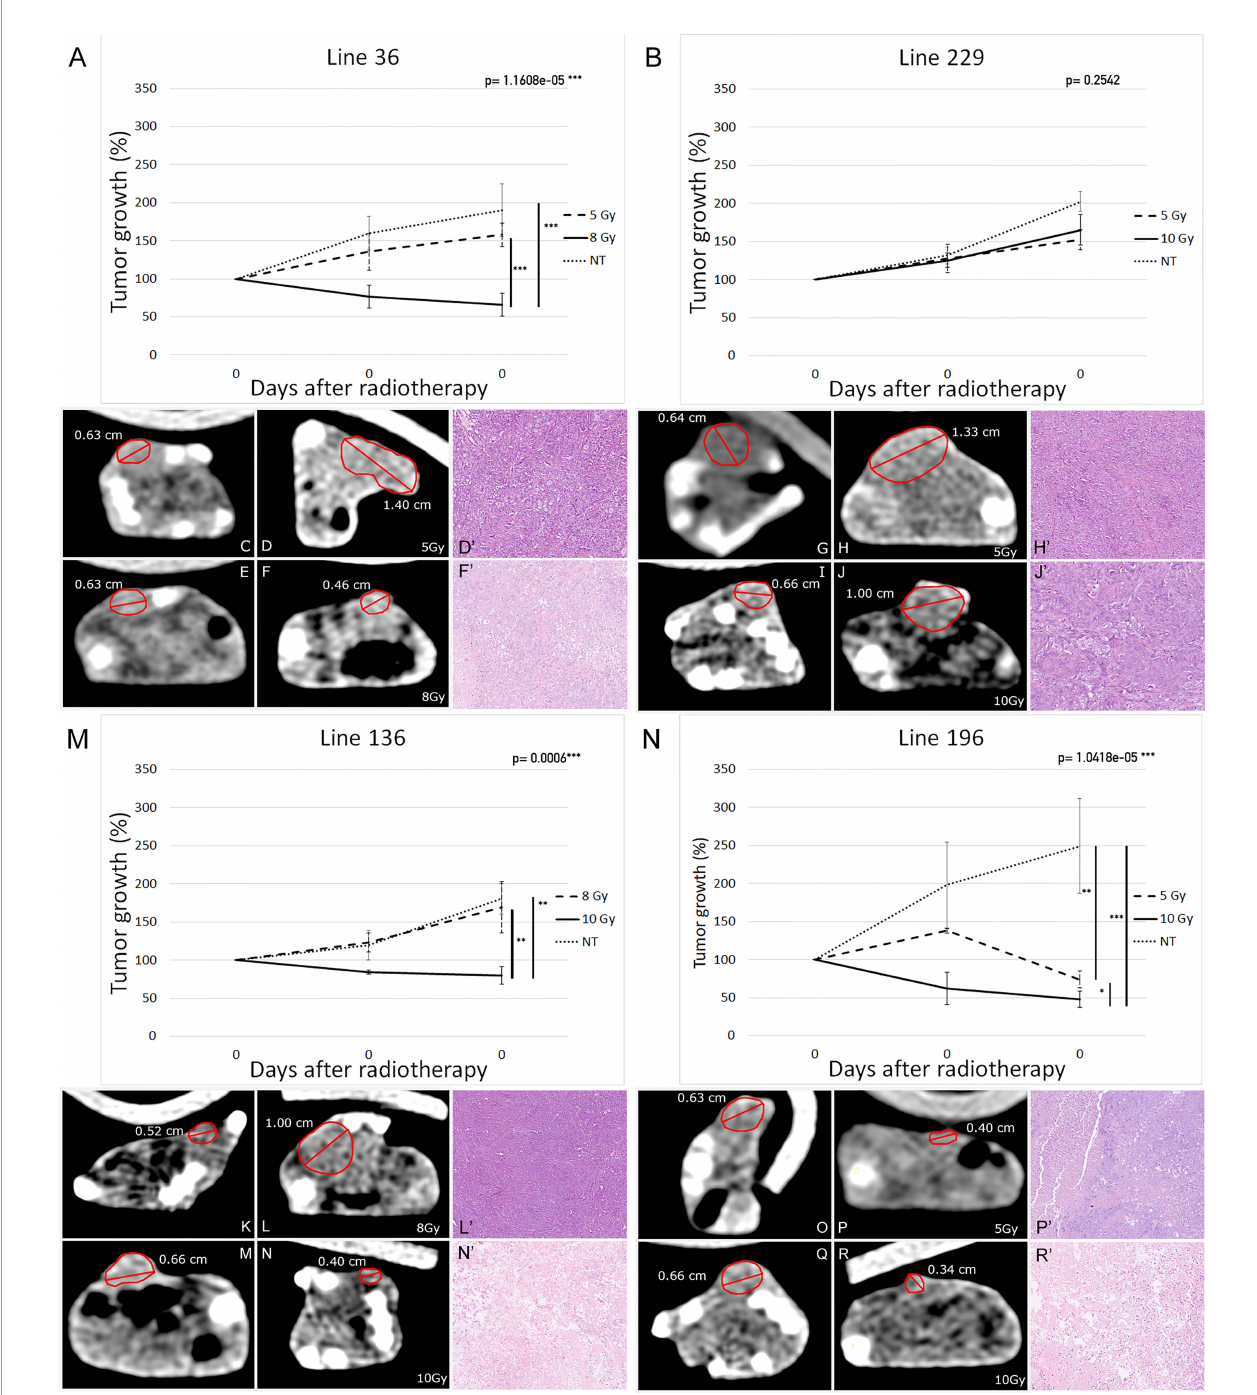
FIGURE 5 | Tumor xenografts ’ volume variation in response to radiotherapy (19 mice per group: eight mice for each of the treatment group and three mice for the NT group). Percentage-volume variation 15 and 30 days after treatment in lines 36 (A) , 229 (B) , 136 (M) , and 196 (N) . Highest Ineffective Doses represented as dashed lines, lowest effective doses represented as continuous lines, and untreated controls represented as dotted lines. Representative CT images before (C, E, G, I, K, M, O, Q) and 30 days after treatment (D, F, H, J, L, M, P, R) in lines 36 (C – F) , 229 (G – J) , 136 (K – M) , and 196 (O – R) at highest ineffective dose (D, H, L, P) and lowest effective dose (F, J, N, R) . Repeated measures ANOVA p-values are reported on top right of each graph. Vertical bars indicate statistically signi fi cant differences between groups of treatment. (*p < 0.05, **p < 0.01, ***p <